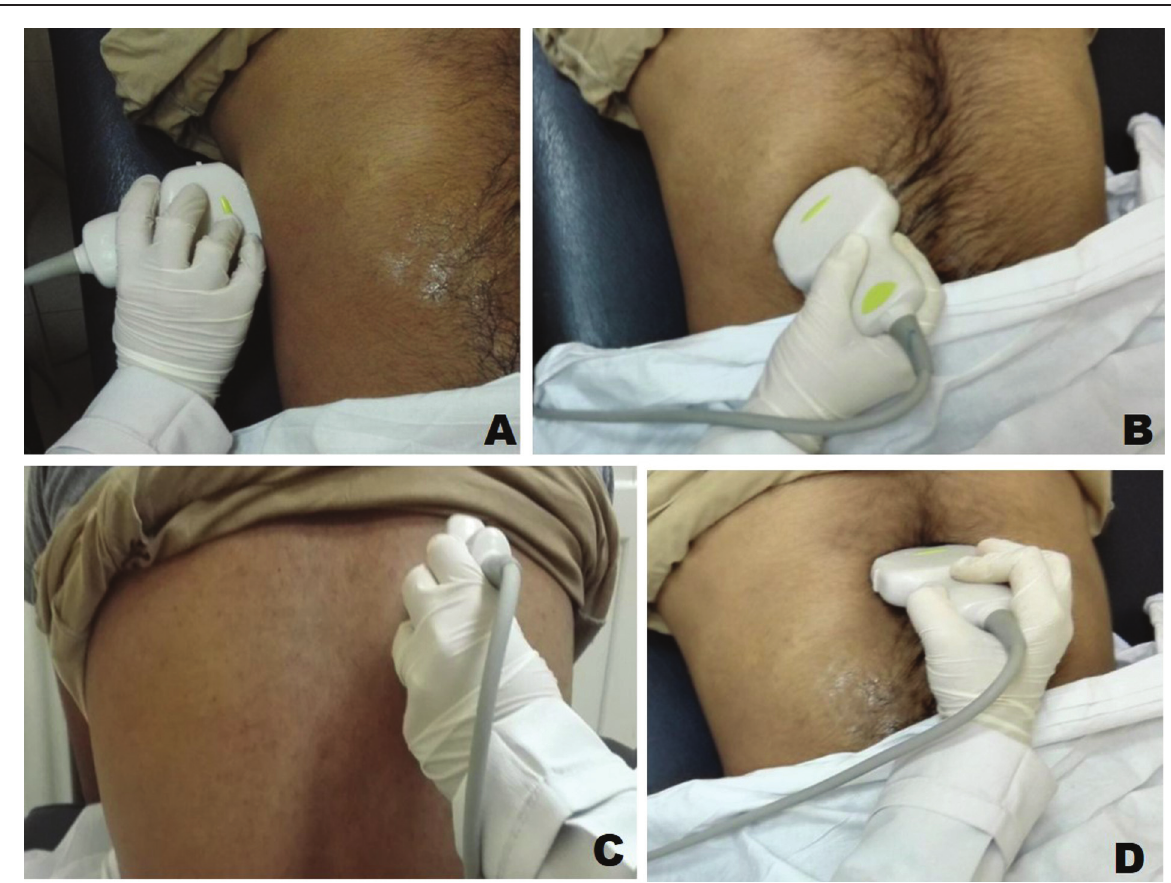
(d) subxiphoid view for qualitative assessment of